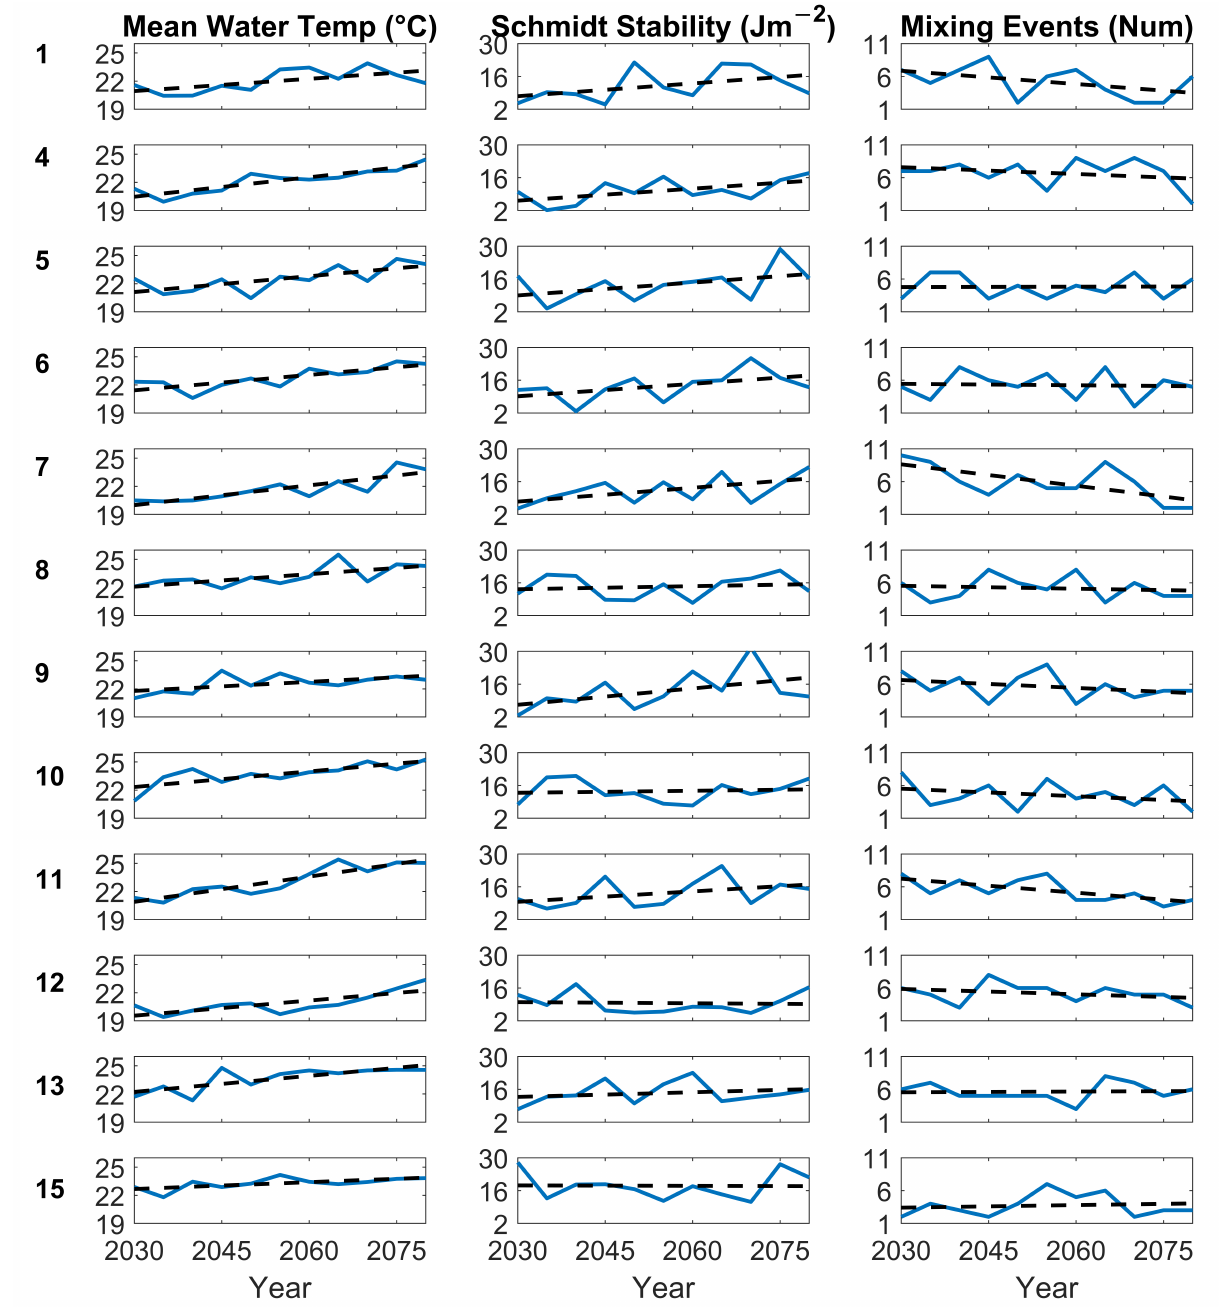
Figure 8. Compiled results from the twelve used UK Climate Projection 2018 (UKCP18) modelled scenarios across the range of years 2030 to 2080 with increasing greenhouse house gases with time, including the mean reservoir temperature, S and number of mixing events each year. Dashed black lines are trend